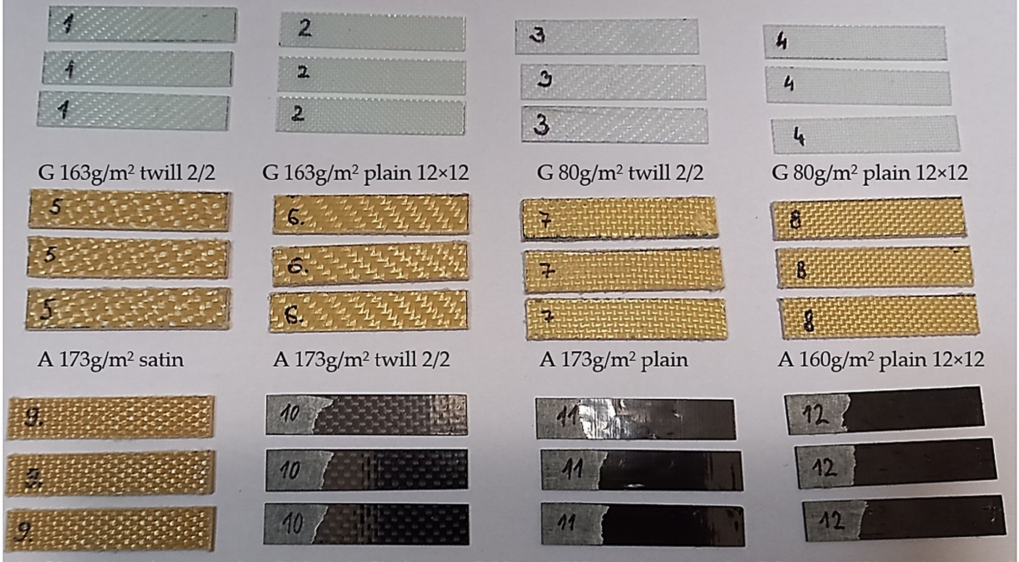
Figure 4. Samples 1–12, multilayered laminate composites, samples: 1–4 with glass fibre fabrics (G), 5–9 with aramid fibre fabrics (A), and 10–12 with carbon fibre fabrics (C) of mass per unit area 80–173 g/m 2 and twill, plain, satin, and unidirectional weave; 1 K, 50 K, and 12 K is yarn size warp; 2/2 is 2-over, 2-under plain weave pattern; 12 × 12 is yarn density warp x weft.